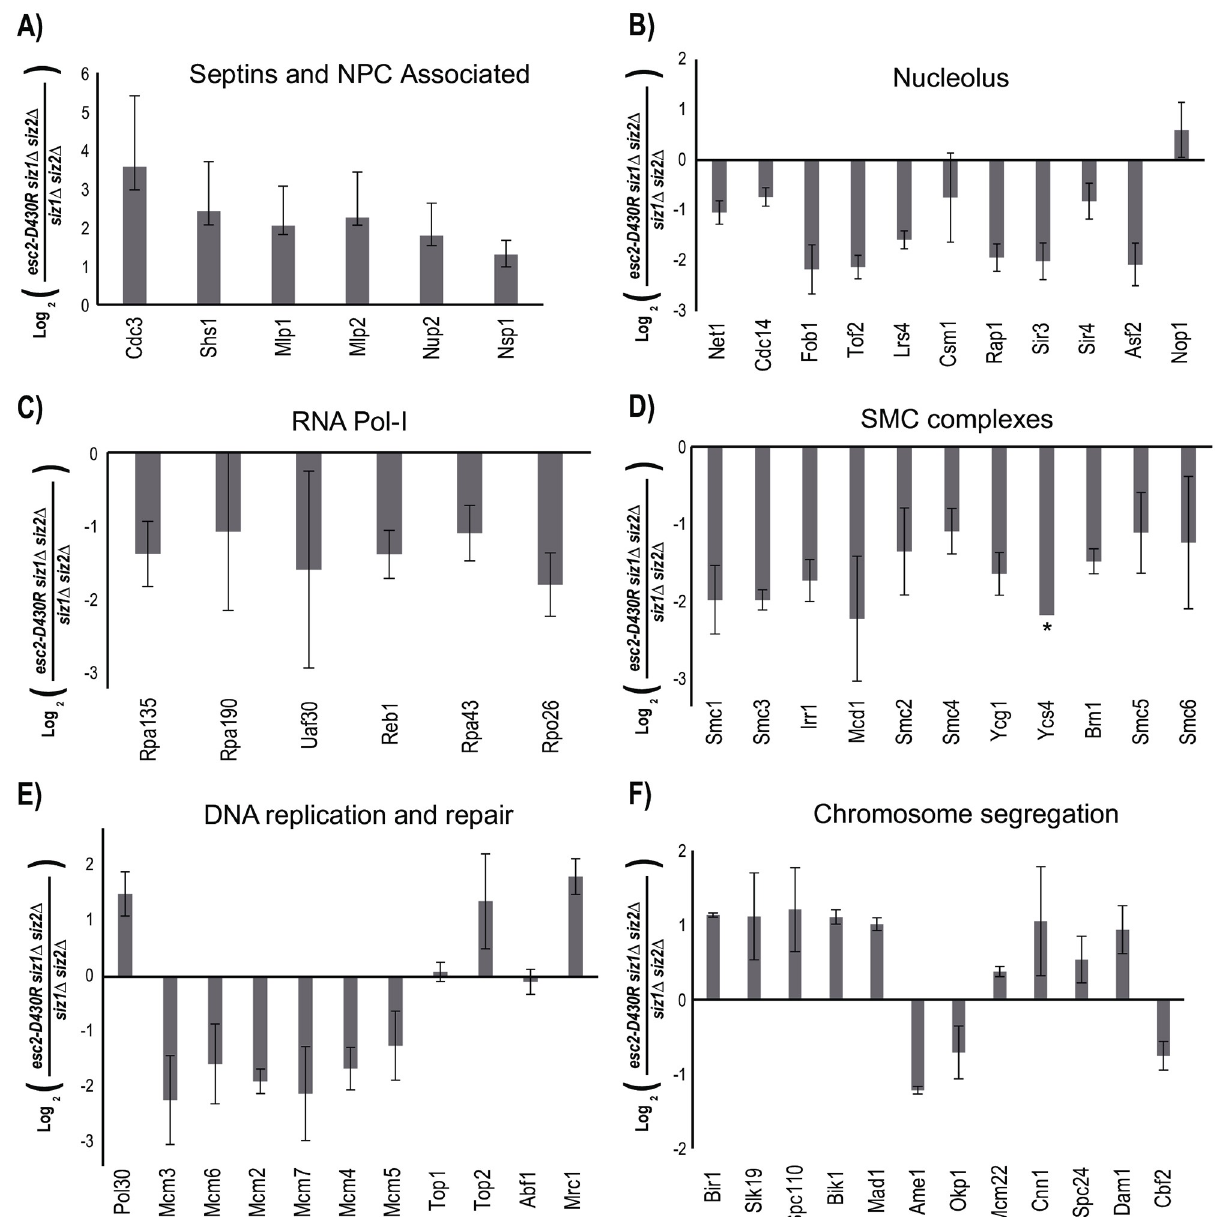
Fig 6. SUMO proteomic approach to evaluate the effect of the esc2-D430R on intracellular sumoylation in cells lacking Siz1 and Siz2, via the comparison of the siz1 Δ siz2 Δ esc2-D430R triple mutant and the siz1 Δ siz2 Δ double mutant. A) Septins, B) NPC associated, C) Nucleolus and RNA Pol-I, D) the SMC complexes, E) DNA replication and repair and F) Chromosome segregation. Log 2 ratios of comparing the relative abundance of each protein in the WT vs the esc2-D430R mutant is shown, along with error bars representing the standard deviation calculated using multiple unique peptides of the same protein (see experimental method for